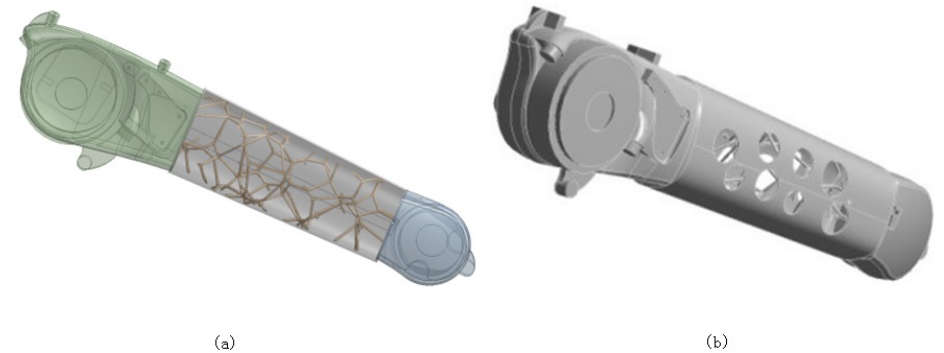
Figure 13. Optimized forearm model: (a) arm model after filling; (b) overall material removal model.